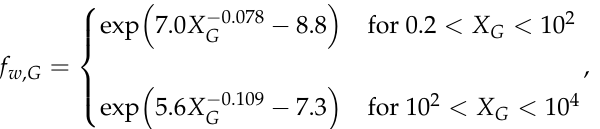
Figure 10. A schematic of the free stream velocity, u f ∞ , and the four characteristic periods ( T 1 , T 2 , T 3 , T 4 ) under a skewed-asymmetric wave, and the positive and negative half-cycles ( T + and T − ). Alternatively, Gonzalez-Rodriguez and Madsen [33] suggested that the development of WBBL under asymmetric waves is different for the wave crest compared to the wave trough. Based on the Gonzalez-Rodriguez and Madsen (GRM07) method, f w , G and l τ , G are different for each phase of the wave, where the subscript G represents the GRM07 method. The duration between the zero up-crossing and u f ∞ , c (zero down-crossing and u f ∞ , where , t u f ∞ represents the minimum free stream velocity), is defined as a quarter sinusoid for the , t wave crest (trough), denoted as T 1 ( T 3 ) (Figure 10). Likewise, the duration between u f ∞ , c and zero down-crossing ( u f ∞ and zero up-crossing) is defined as T 2 ( T 4 ). The summation of T 1 , t and T 2 ( T 3 and T 4 ) is defined as T + = T 1 + T 2 ( T − = T 3 + T 4 ), representing the duration of positive (negative) free stream velocity under the wave crest (trough). At the timings of maximum and minimum free stream velocity, i.e., at t = t c and t = t t , two wave friction factors ( f w , G ( t c / T ) and f w , G ( t t / T ) ) and two time-lag parameters ( l τ , G ( t c / T ) and l τ , G ( t t / T ) ) were separately calculated using the equations similar to Equations (10) and (11)